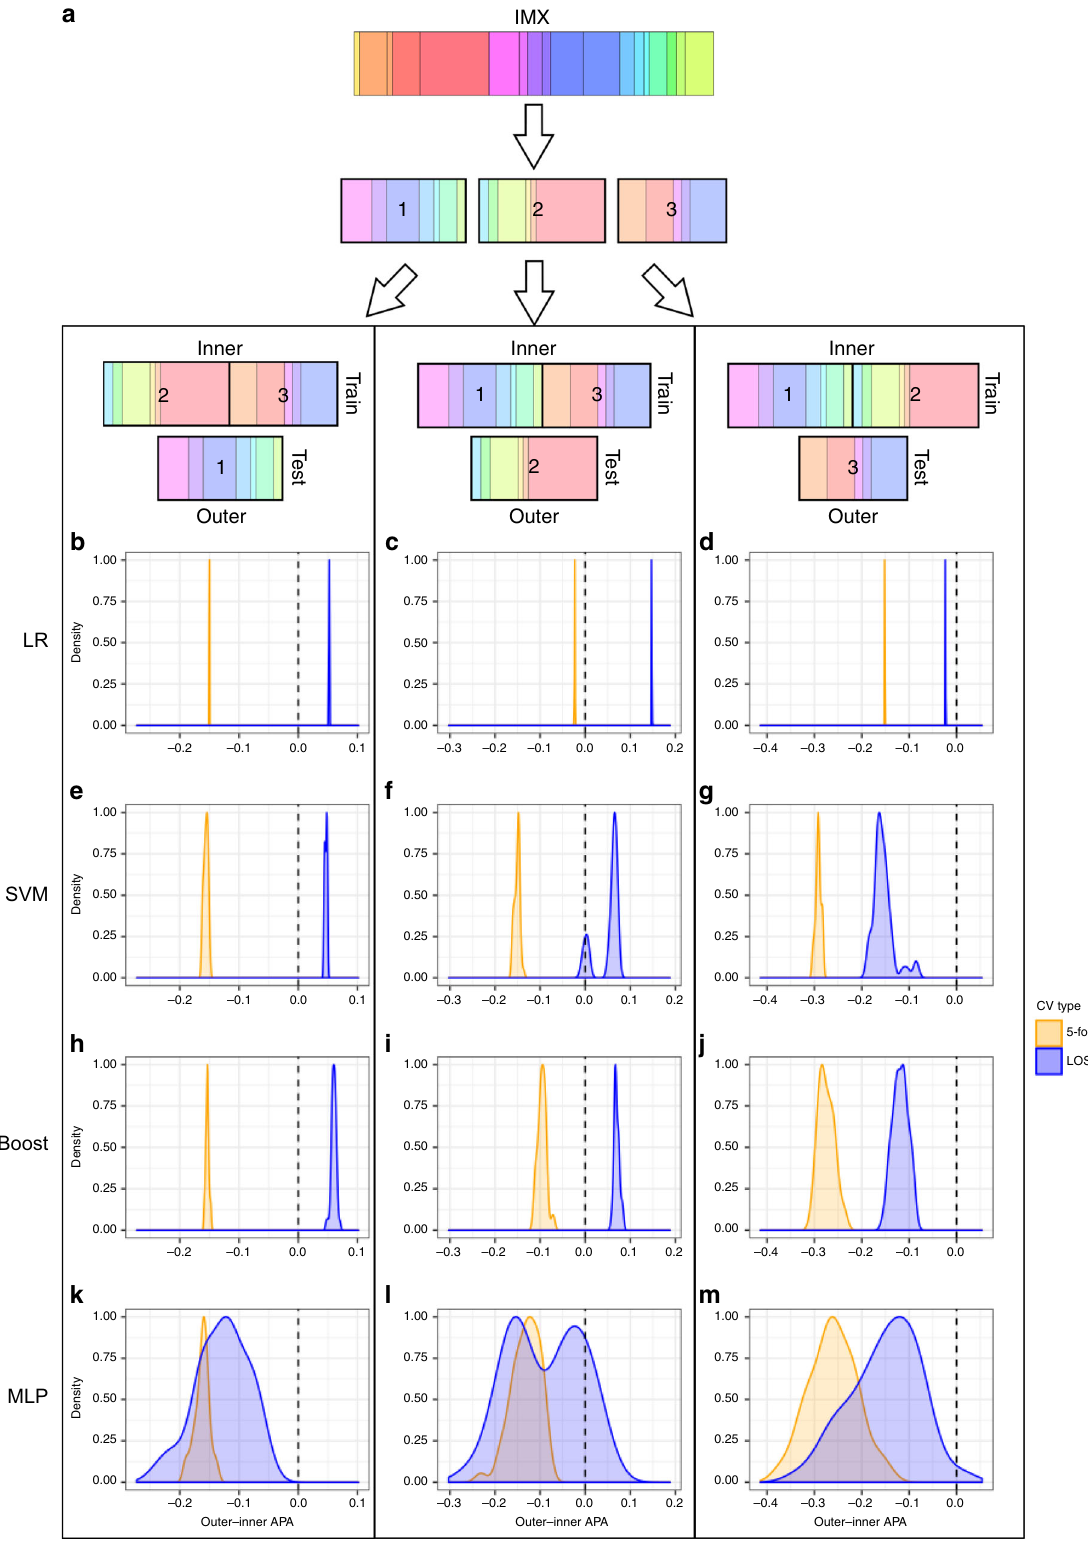
Discussion Despite intense study in multi-mRNA host-response diagnostics for acute infections and sepsis over the past two decades 15,24 – 38 , no multi-mRNA panel combined with a machine learning algo- rithm has been successfully applied with fi xed weights in external